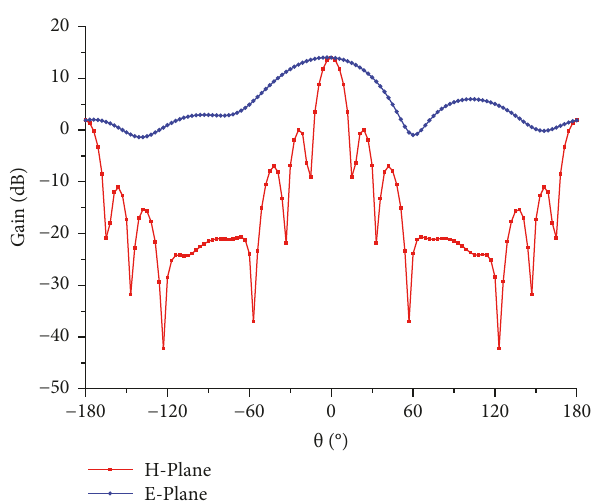
Figure 9: E-plane and H-plane radiation patterns of the DRA array at 12